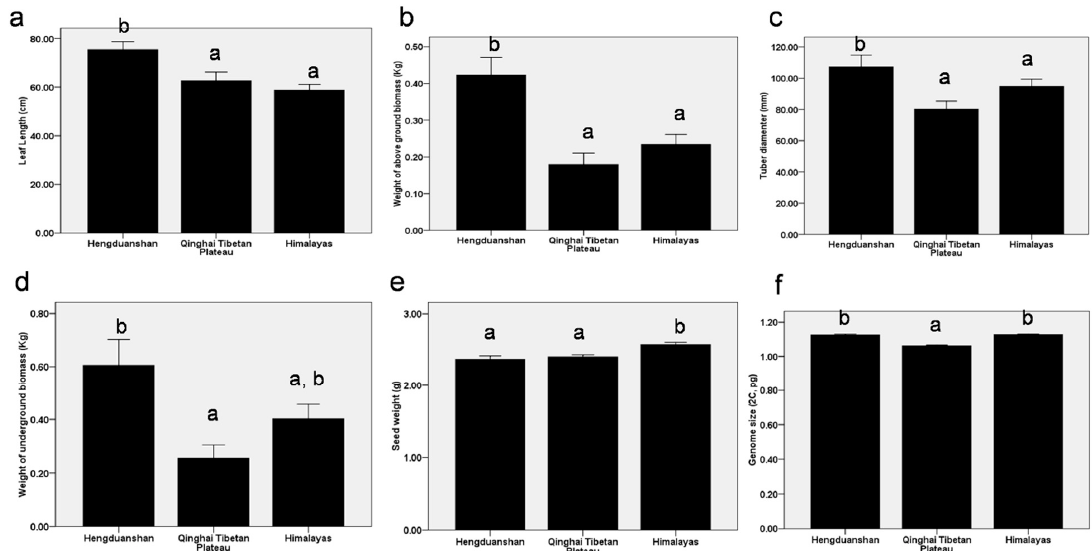
Figure 2. Variation in morphological traits and genome size among the three environments selected in this investigation. The bar diagrams show ( a ) average leaf length, ( b ) average weight of above ground biomass, ( c ) average tuber diameter, ( d ) average weight of underground biomass, ( e ) average seed weight, and ( f ) average genome size investigated from three environments. The histograms with same letters are statistically similar estimates ( p <0.01).